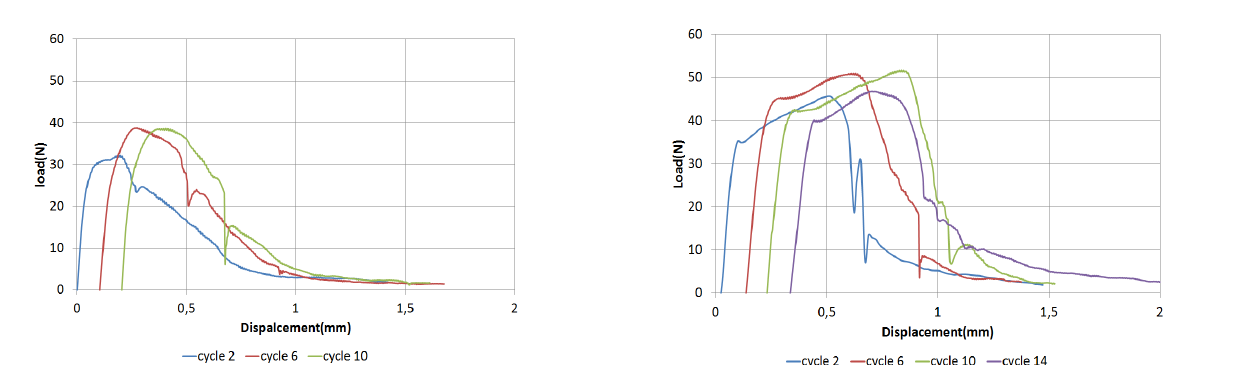
Figure 15: Load vs displacements plot of the extraction test carried out with gel lubricant.